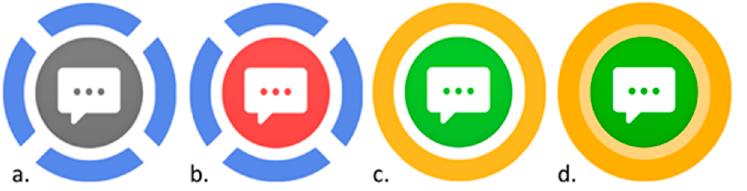
Figure 6. Four states of gesture interaction presented visually to the driver—( a ) Idle state, ( b ) Warning State, ( c ) Hover state, and ( d ) Selected state.